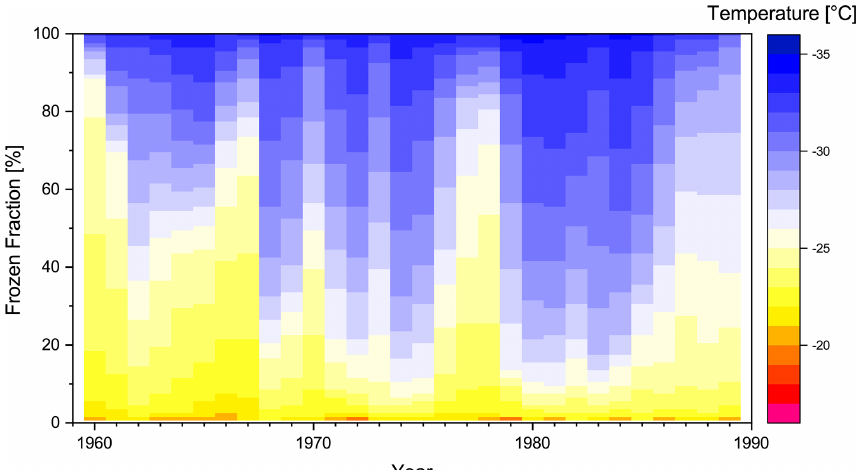
Figure 7. Frozen fractions of the modern-day samples depending on freezing temperature (colors). The temporal coverage of an individual sample typically averages over about 6 months. However, data points are interpolated in time to generate yearly columns of regular width. The non-interpolated data are presented in Fig.